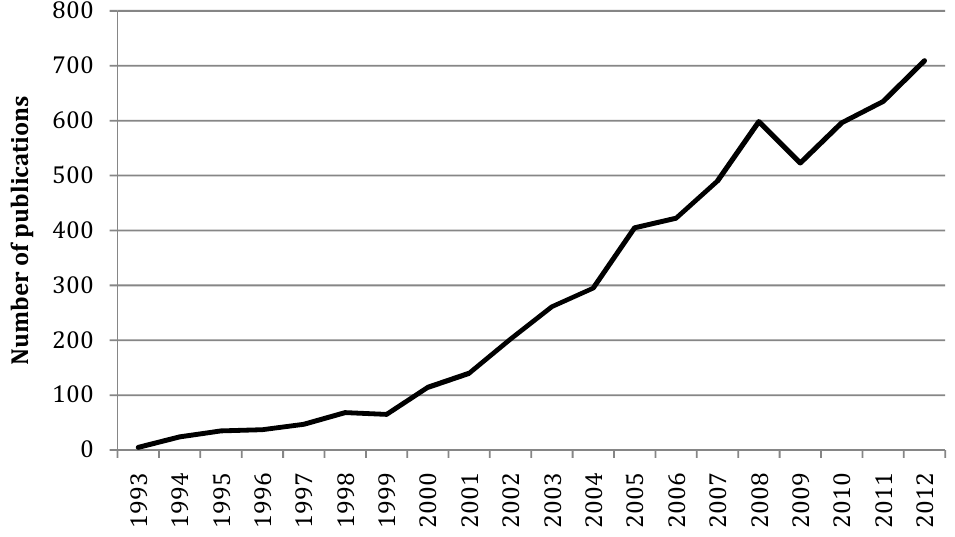
Figure 1. All publications in Google Scholar containing the search terms “household survey” and “biodiversity” from 1993 to